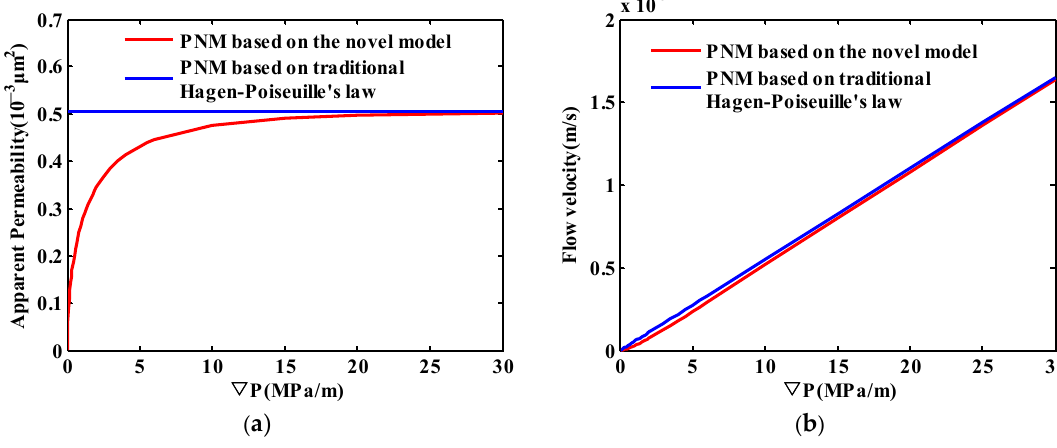
Figure 17. Relationship between apparent permeability and flow rate versus ∇ P : ( a ) Apparent permeability versus ∇ P ; ( b ) Flow velocity versus ∇ P.